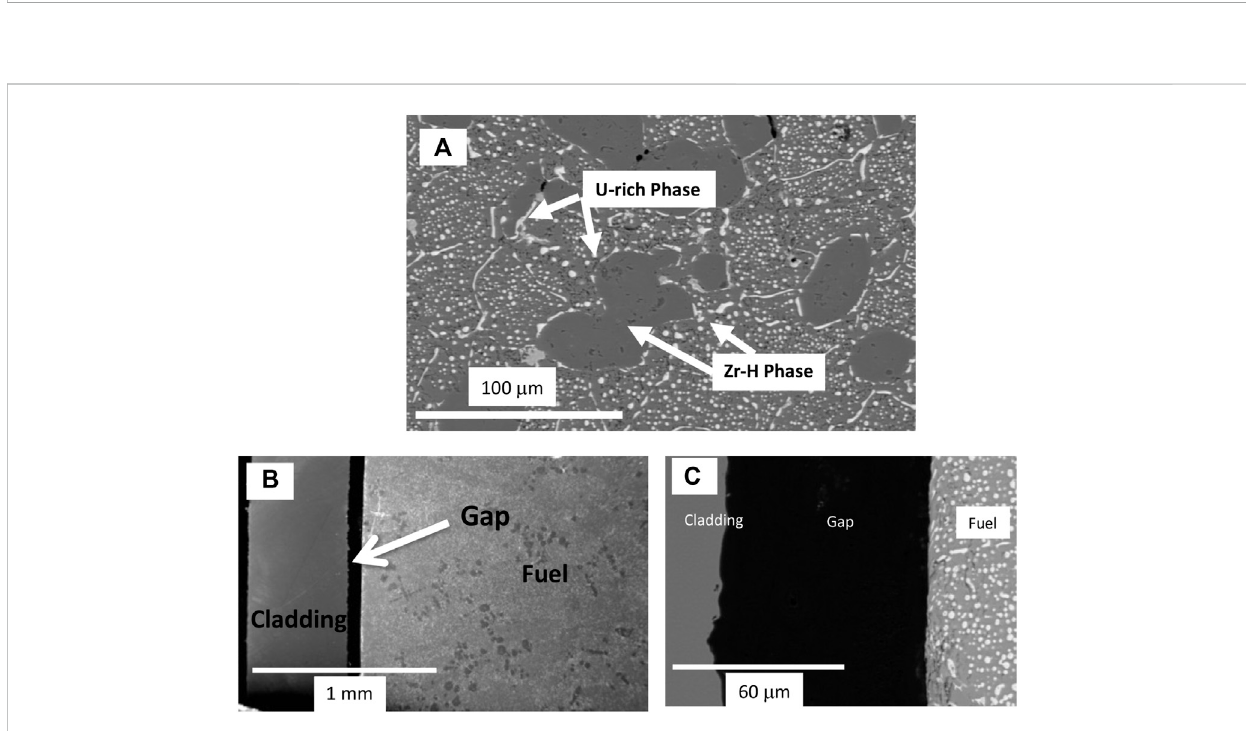
Backscattered electron images (A – C) showing the as-irradiated TRIGA fuel microstructure (A) and a gap (B,C) that was observed at the fuel and cladding